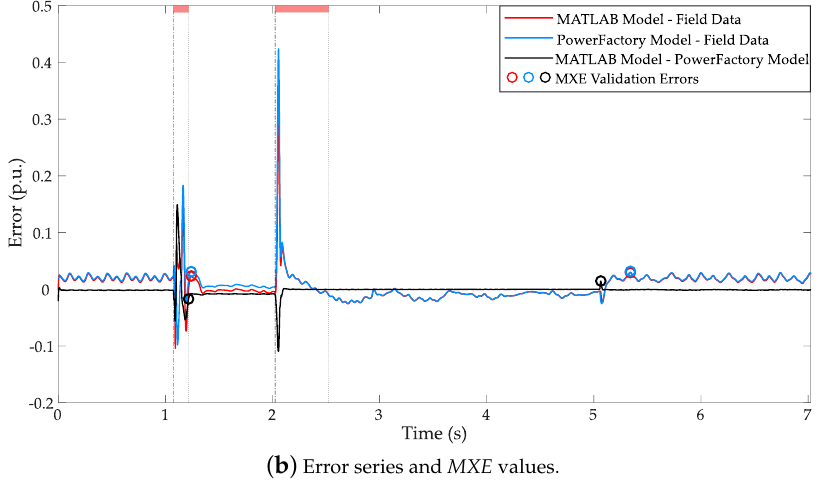
Figure 10. Reactive power in Test Case 1: u = 0.50 pu, t = 920 ms.